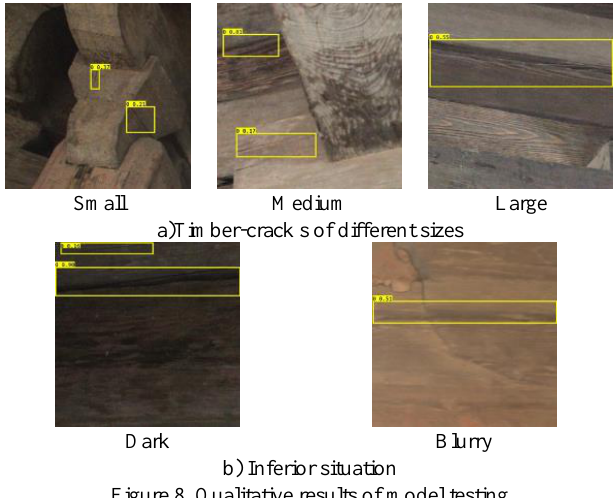
Figure 8. Qualitative results of model testing